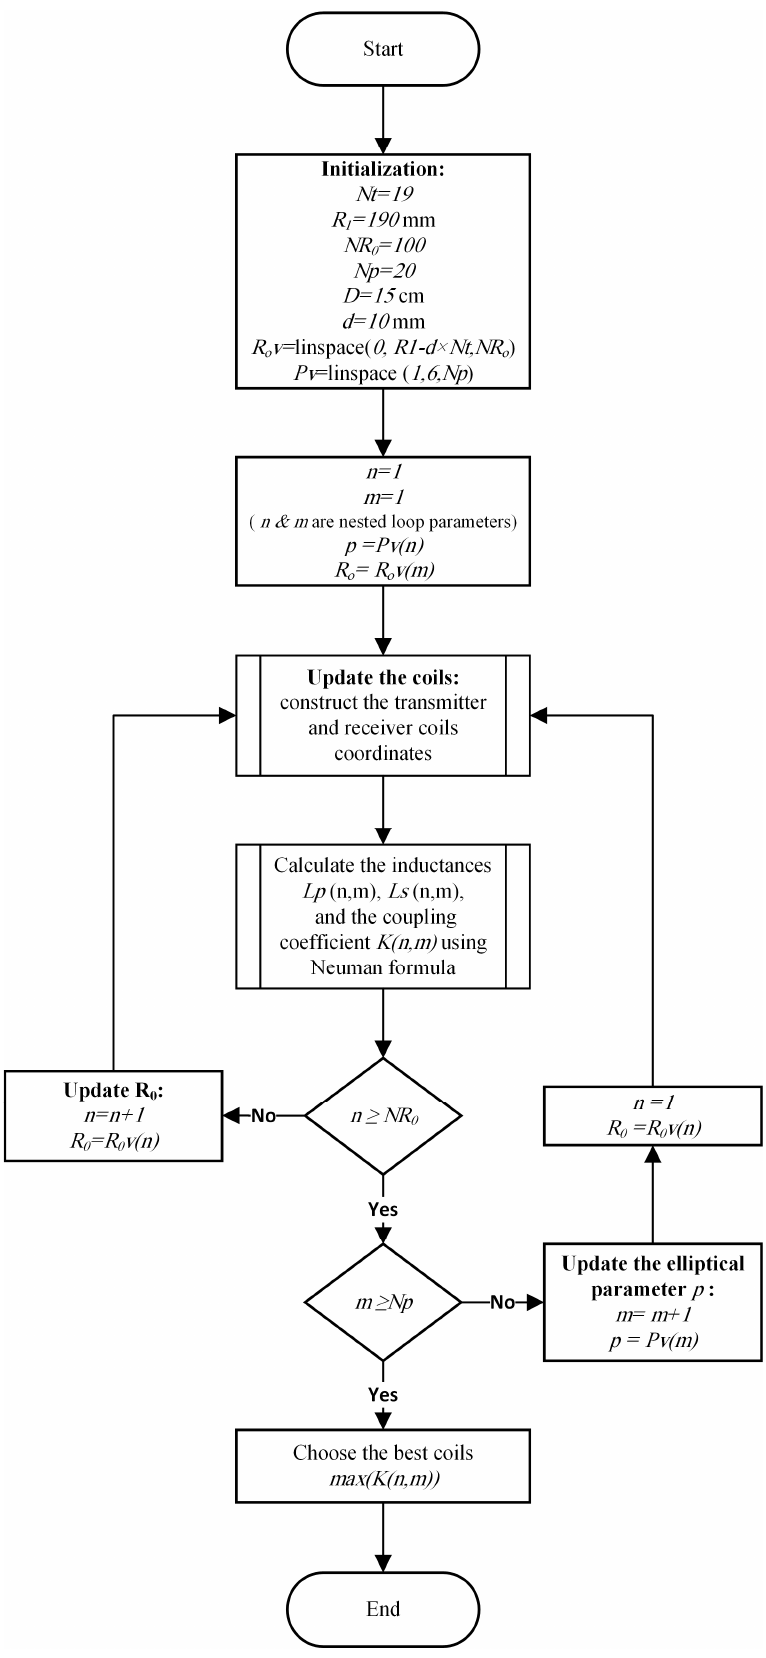
Figure 3. An optimization process flow chart for designing WPT coils.